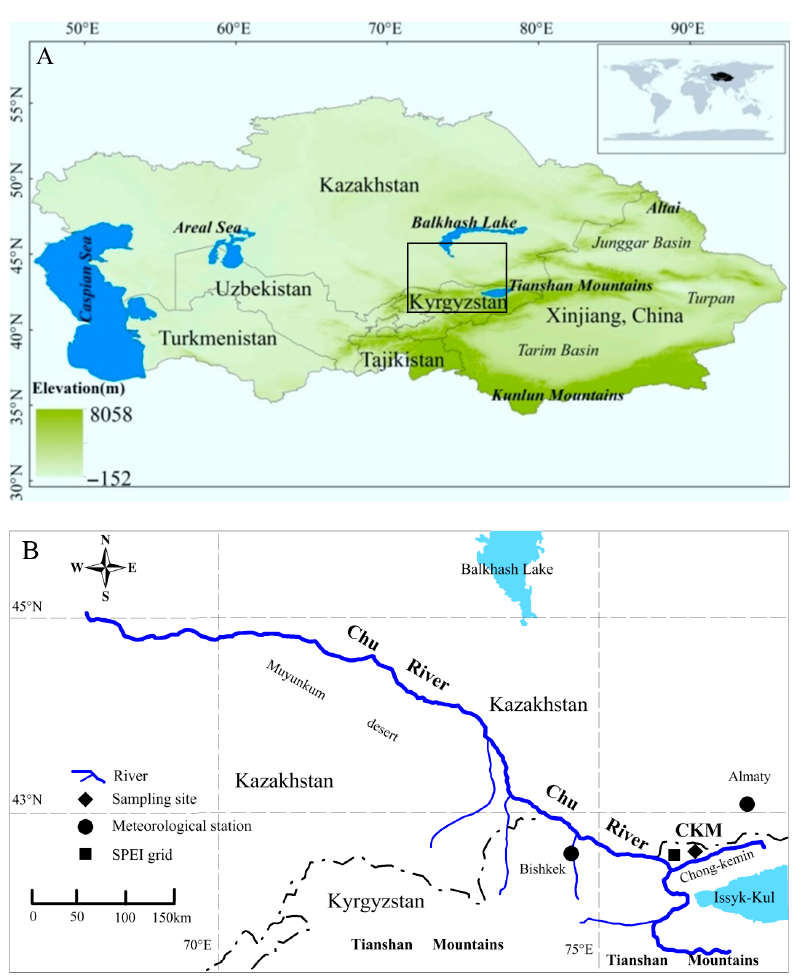
Figure 1. Map of tree-ring sample sites information. ( A ) Map of arid Central Asia; ( B ) Sketch map of tree-ring sampling site, meteorological station and SPEI grid.